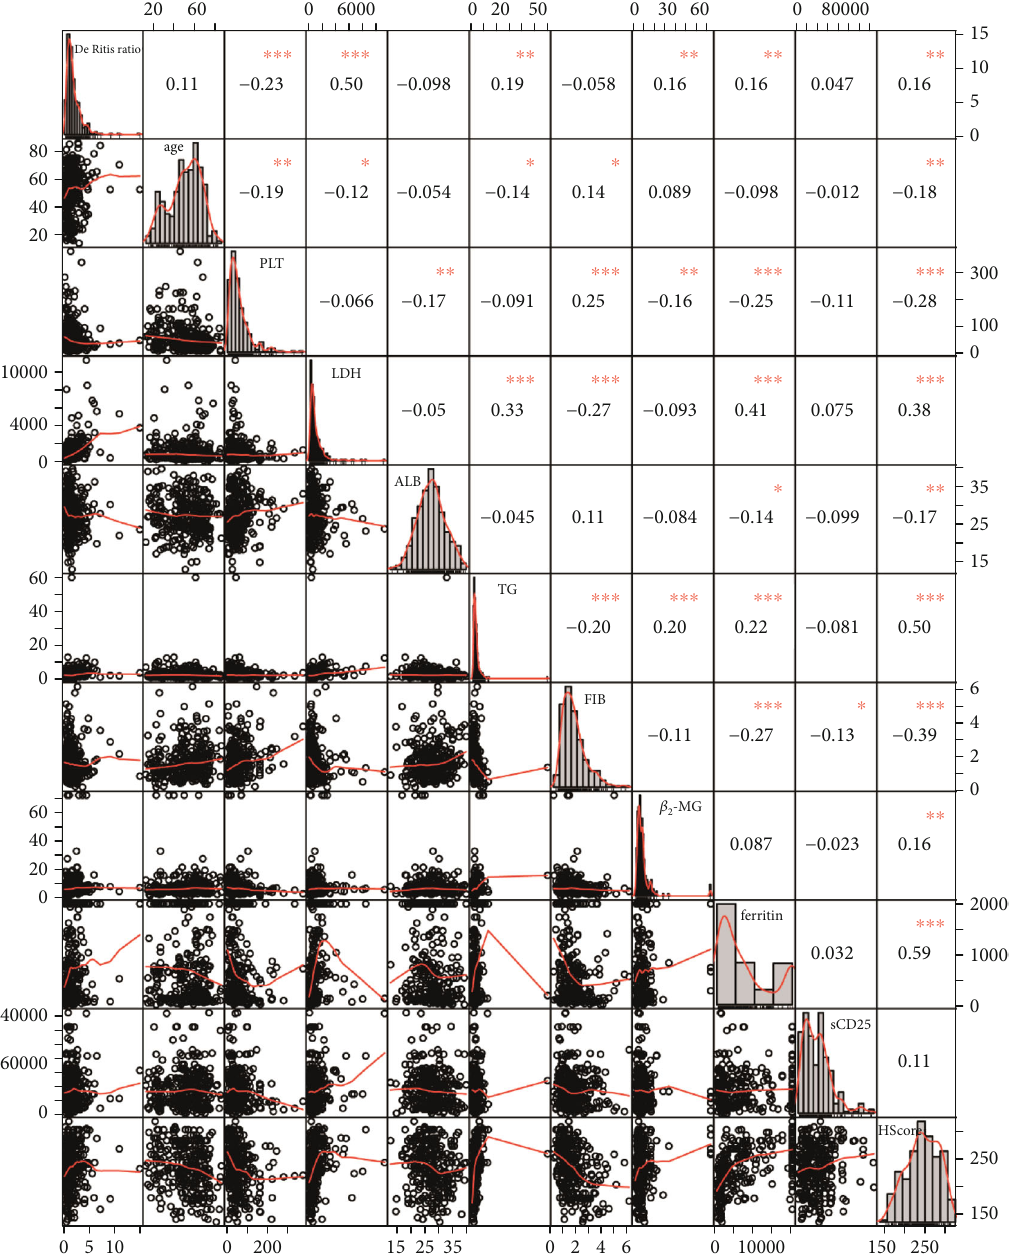
Figure 2: Pairwise correlation between the De Ritis ratio (AST/ALT) and age, platelet (PLT), lactate dehydrogenase (LDH), albumin (ALB), -MG), ferritin, Soluble IL-2 receptor (sCD25), and Hscore triglyceride (TG), fi brinogen (FIB), beta2-microglobulin ( β 2